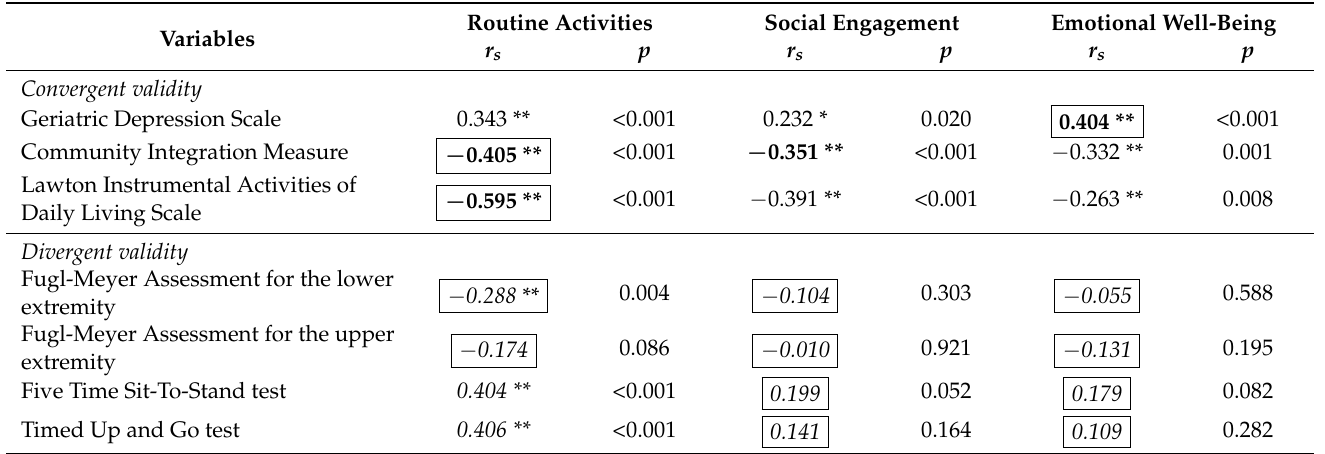
Table 4. Convergent and divergent validity of the Chinese version of the Oxford Participation and Activities Questionnaire.